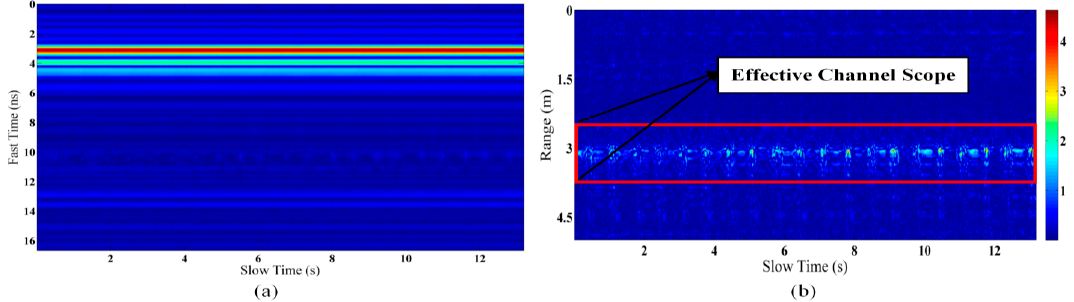
Figure 3. SFCW radar signal of a piaffe at a position 3 m behind the wall. ( a ) Original signal. ( b ) Preprocessed signal.